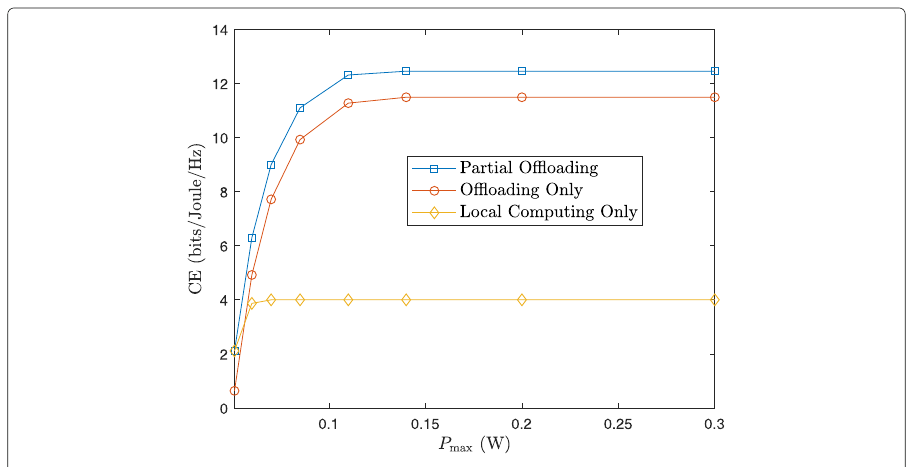
Fig. 6 Comparison of CEs among different computing modes